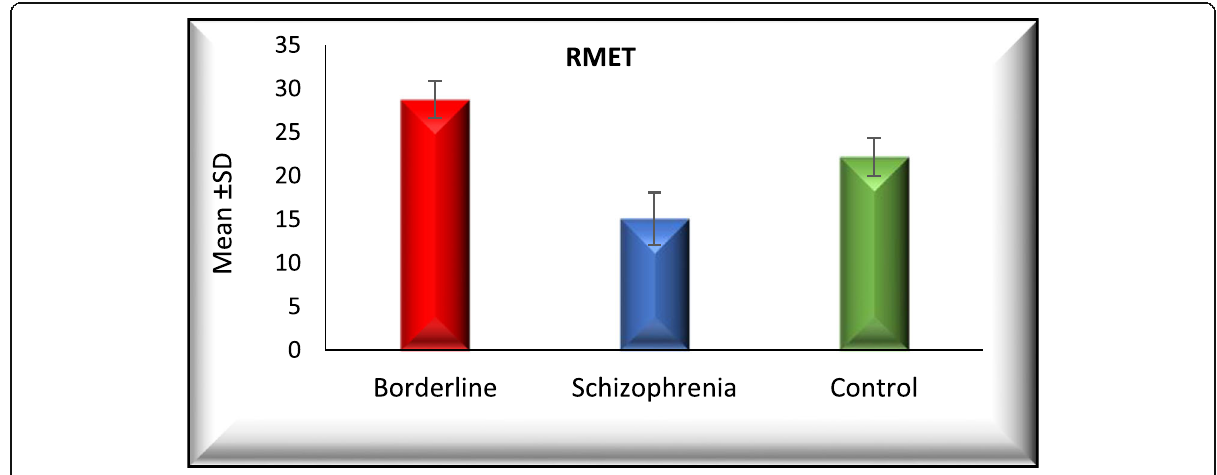
Fig. 1 Comparison of RMET mean score between the studied groups